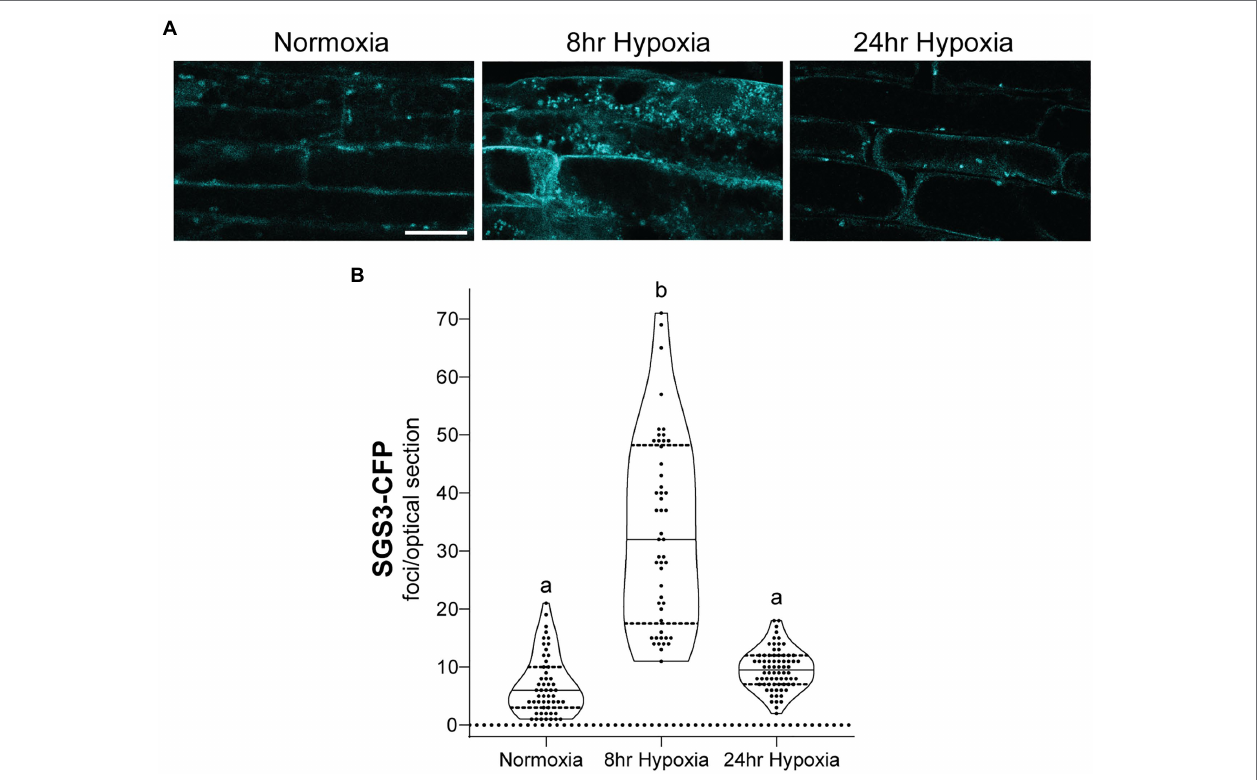
FIGURE 3 | SGS3 body formation and turnover during hypoxia. (A) Confocal micrograph of representative Arabidopsis thaliana Col-0 epidermal root cells from SGS3-CFP plants during normoxia and hypoxia time course. All micrographs are the same scale. Scale bar is 25 μ m. (B) Violin plot of quantitation for the number of SGS3-CFP foci from A. Each data point represents quantitation of a 2 μ m optical section from a single cell. Different letters represent statistically significant differences ( p < 0.0001) assessed by one way ANOVA